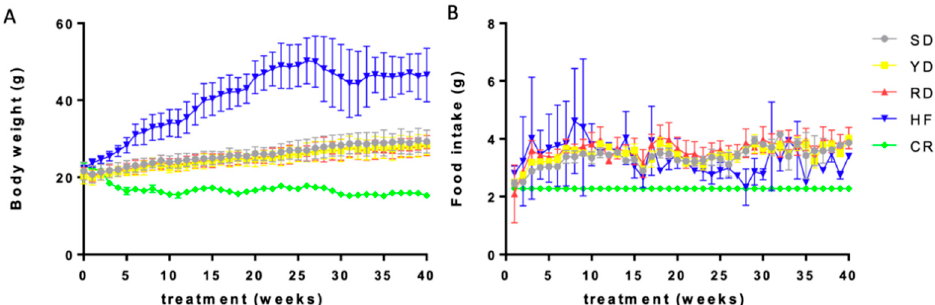
Figure 1. Weight gain and food consumption in different diets: Body weight of mice ( A ) and average daily food intake per mouse per week ( B ) for the different diets, SD, CR, HF, YD, and RD, as indicated by the color list.